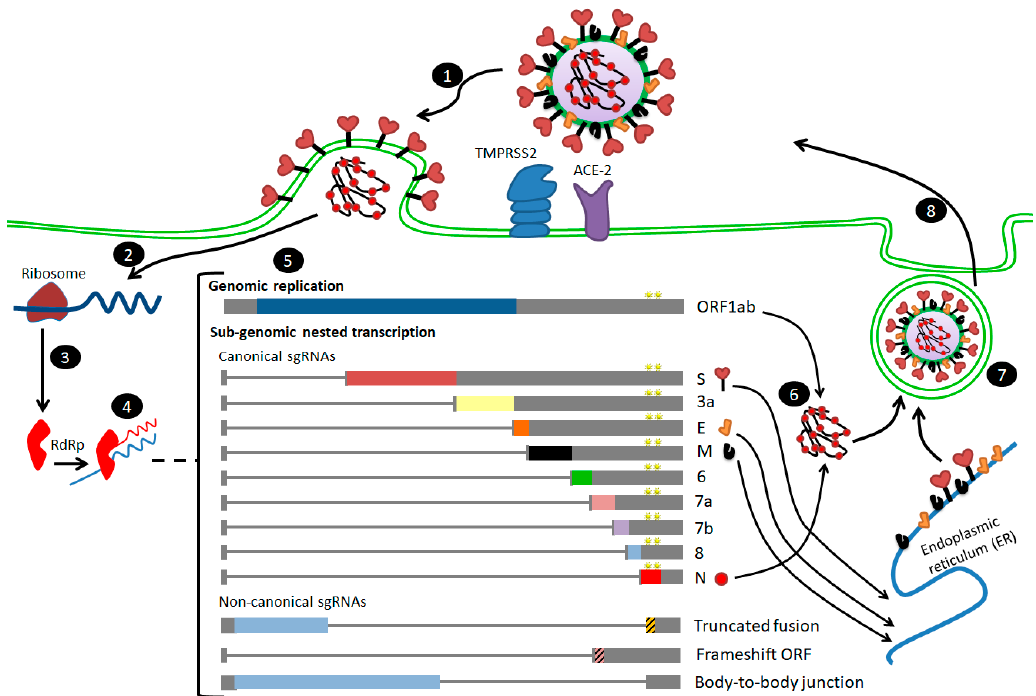
Figure 2. Steps of SARS-CoV-2 infection and entry to the host cell [14,29]. ( 1 ) After receptor (angiotensin-converting enzyme 2 (ACE2)) binding, the virus enters host cell cytosol via cleavage of S protein by a protease enzyme (transmembrane protease serine 2 (TMPRSS2)), followed by fusion of the viral and cellular membranes. ( 2 ) Upon cell entry, the genomic RNA is translated to produce non-structural proteins from two open reading frames, ORF1a and ORF1b. ( 3 ) Some of the nsps have RNA-dependent RNA polymerase (RdRp) activity (nsp12). ( 4 ) Negative-sense RNA intermediates are generated to serve as the templates for the synthesis of positive-sense genomic RNA (gRNA), and ( 5 ) sub-genomic RNAs (sgRNAs). ( 6 ) The gRNA is packaged by the structural proteins to assemble progeny virions. Shorter sgRNAs encode conserved structural proteins (S, E, M and N), and several accessory proteins. SARS-CoV-2 is known to have at least six accessory proteins (3a, 6, 7a, 7b, 8 and 10), and non-canonical sgRNAs are also shown in the figure. The AAGAA-type modification clusters in gRNA and sgRNAs are shown with yellow stars annotations. ( 7 , 8 ) budding and exocytosis of the virus